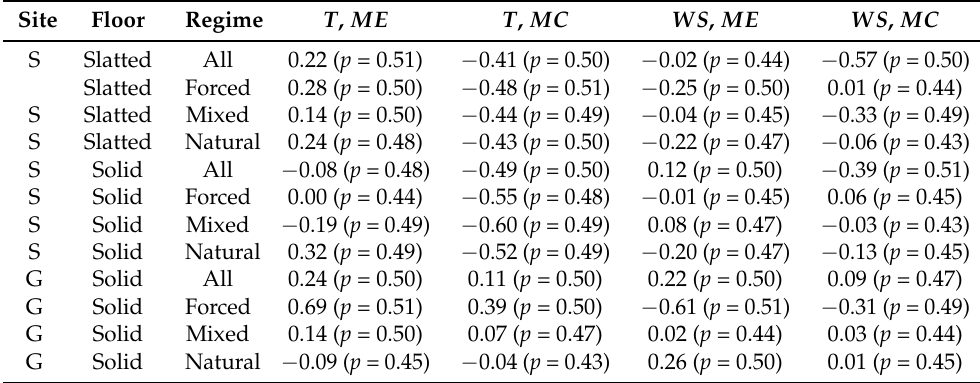
Table 4. Spearman’s rank correlation between air temperature ( T ), wind speed ( WS ), CH 4 emission ( ME ) and CH 4 concentration ( MC ). For each site (i.e., S = Switzerland, G = Germany) and flooring system, the correlation was calculated based on all data as well as based on subsets associated with the regimes forced, mixed and natural convection. p -values in brackets indicate the exceedance probability of normally distributed random variable sets (see Section 2.4.3).